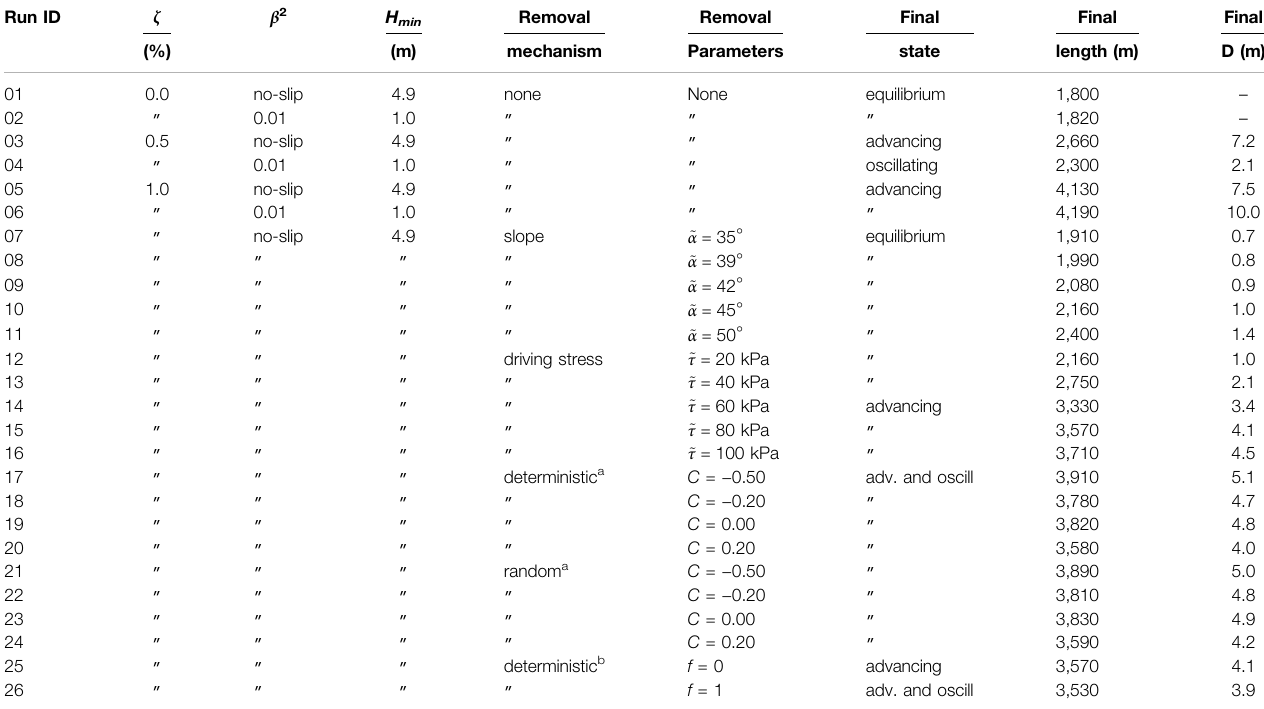
TABLE 1 | Overview of performed simulations. Runs with debris-free glaciers (ID 01 and 02) end when the glaciers reach steady state. All other simulations run for 6,000 years. The last three columns report glacier states after those simulation times. Non-equilibrium states may change running the model over longer time periods. Run